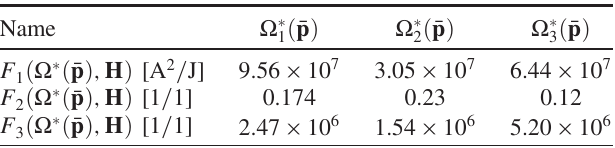
TABLE III. Results for the 1D constrained optimization — objective